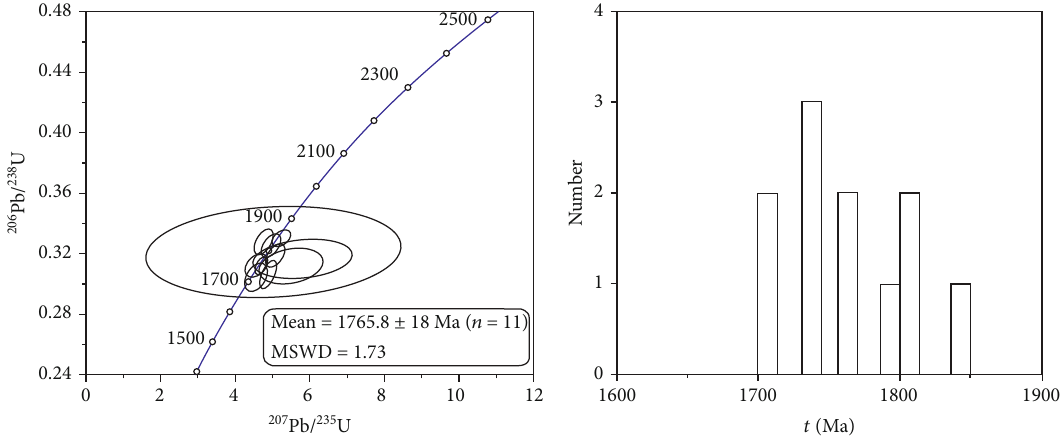
Figure 5: The zircon U-Pb age Concordia diagram and histogram of